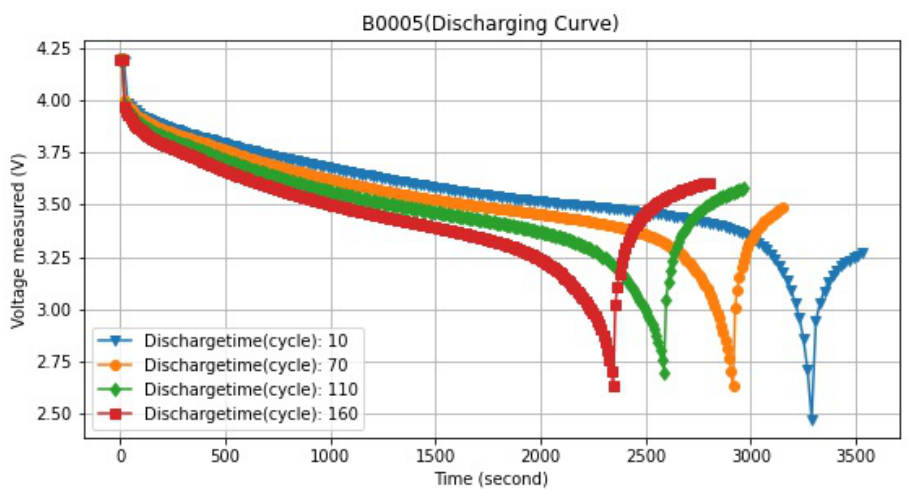
Figure 6. Voltage measured with different cycles.